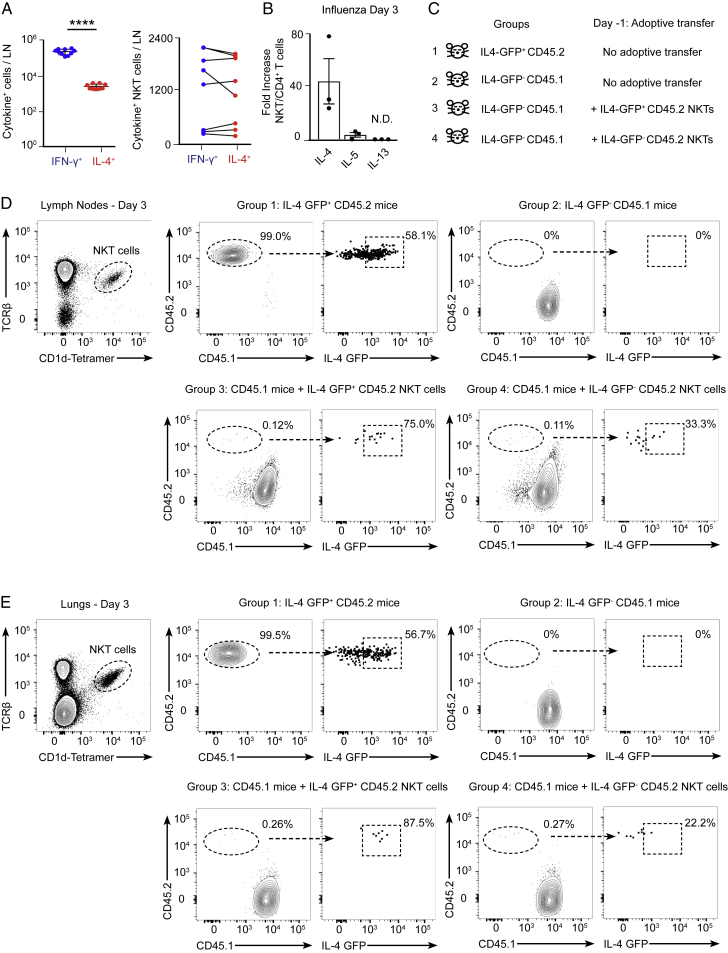
Analysis of the NKT Cell Source of IL-4, Related to Figure 3(A) Quantification of IFN-γ+ (blue) and IL-4+ (red) producing lymph node (left chart) or NKT cells (right chart) in mediastinal lymph nodes after 3 days of influenza infection.(B) RT-qPCR analysis of IL-4, IL-5 and IL-13 expression at day 3 of influenza infection by sorted NKT cells compared to CD4+ T cells. Each dot represents one mouse.(C) Adoptive transfer strategy for the analysis of the source of IL-4+ NKT cells after influenza infection.(D and E) Flow cytometry analysis at day 3 of influenza infection of (D) mediastinal lymph node or (E) lung NKT cells from mice that were treated as in (C) to detect IL4-GFP expression.Data are representative from two experiments.